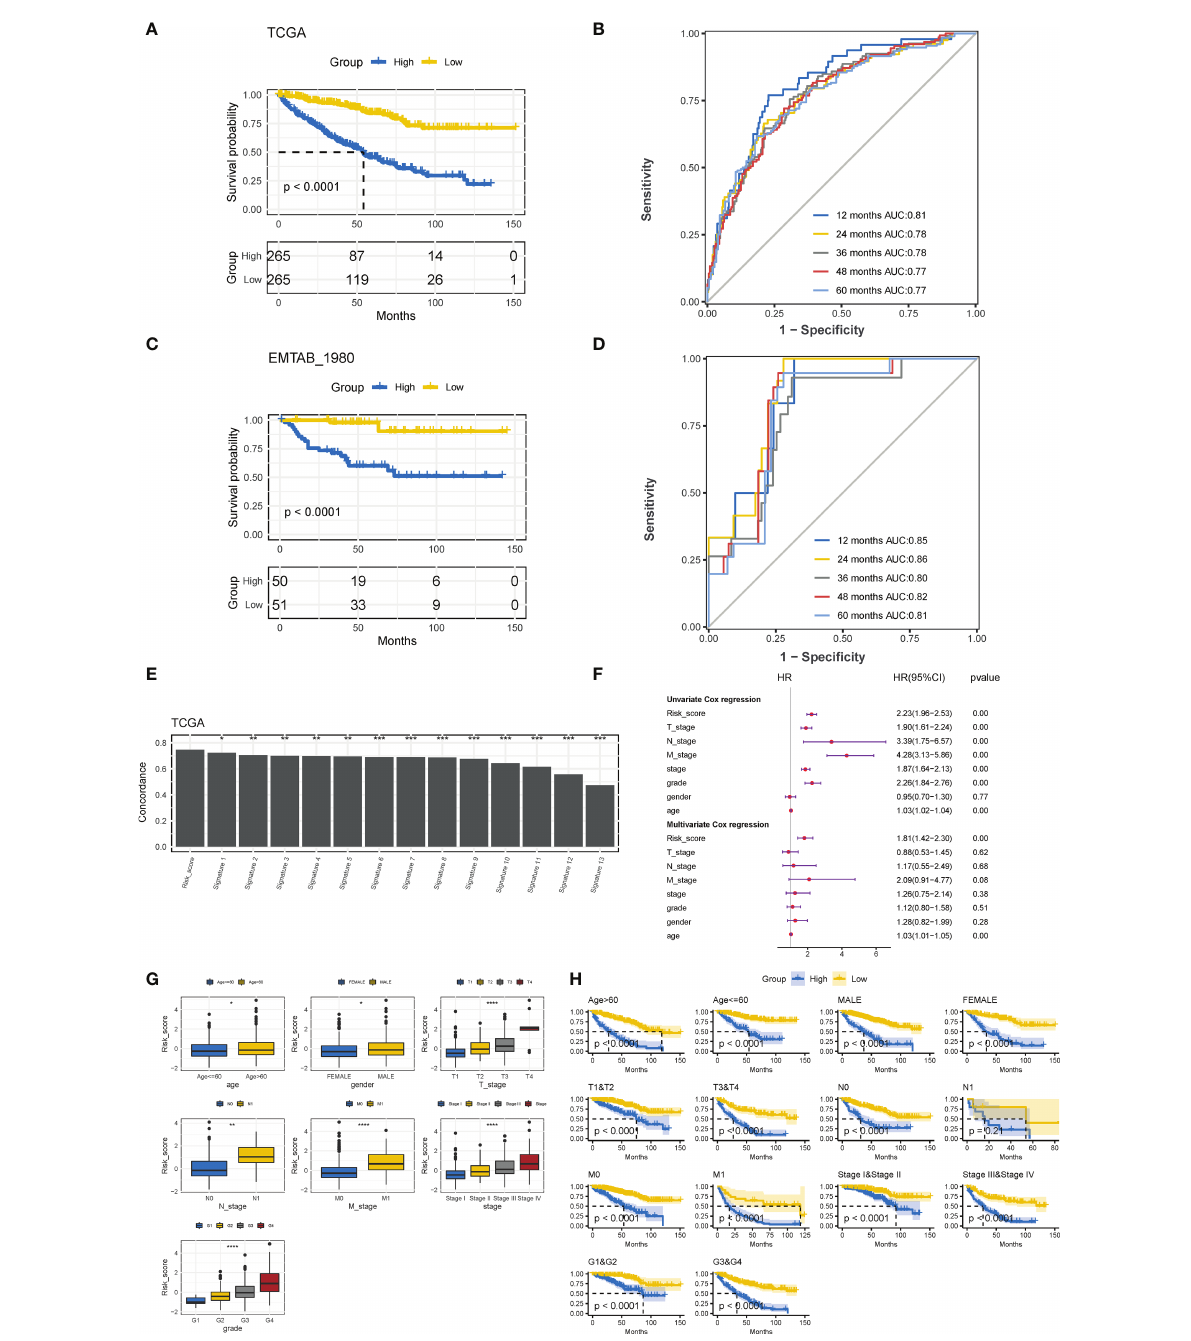
FIGURE 5 EvaluationandvalidationofprognosticpredictiveaccuracyofCTRsignature. (A) Kaplan – Meiersurvivalanalysisofthedifferenceintheoverallsurvival(OS) betweenccRCCpatientswithhighandlowclaudin-TMErelated(CTR)scoreinTheCancerGenomeAtlas-kidneyclearcellcarcinoma(TCGA-KIRC)training cohort.PatientsweredichotomizedintohighorlowCTRgroupsbasedonthemedianCTRscore. (B) Time-dependentreceiveroperatingcharacteristic(ROC) curvesat1 – 5yearsinthetrainingcohort. (C) Kaplan – MeierestimatesofthedifferenceintheOSbetweenccRCCpatientswithhighandlowCTRscoresinthe validationcohort(E-MATAB-1980).PatientswerealsodichotomizedintohighorlowCTRgroupsbasedonthemedianCTRscore. (D) Time-dependentarea undertheROCcurve(AUC)valueinthevalidationcohort. (E) Differenceintheconcordanceindex(C-index)betweentheClinicalRiskGroups(CTR)scoreand otherpreviouslyreportedprognosticmodelsinTCGA-KIRC. (F) ForestplotofhazardratiosforCTRscoreandclinicopathologicvariablesintheTCGA-KIRC dataset. (G) DifferenceinthedistributionofCTRscoresbetweenpatientswithdifferentclinicopathologicvariables. (H) Kaplan – MeiersurvivalanalysisoftheCTR scorestrati fi edbydifferentclinicopathologicfeature.*p<0.05,**p<0.01,***p<0.001,****p<0.0001.CTRscore,claudin-TMErelatedriskscore;AUC,area